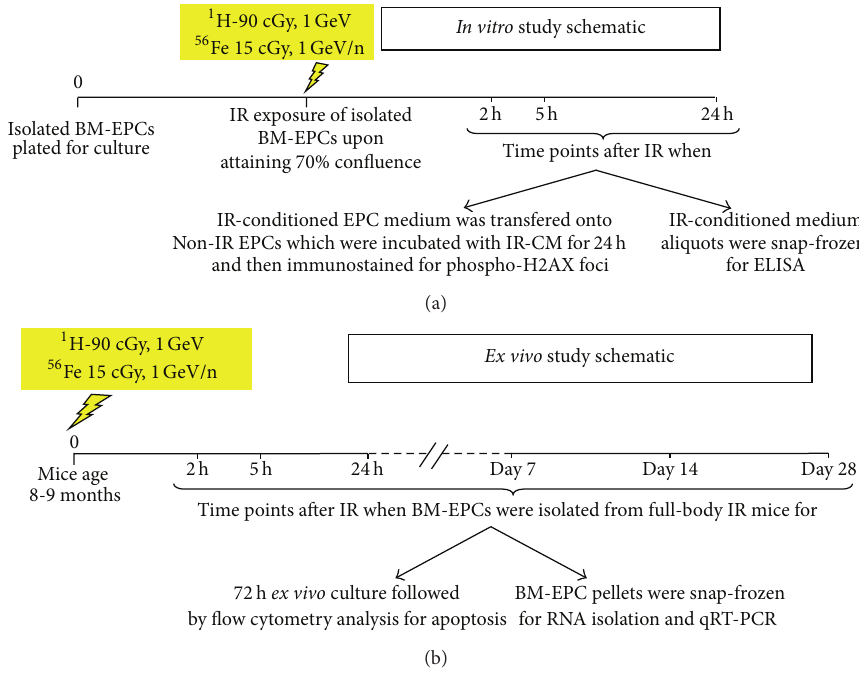
Figure 1: Diagrammatic representation of the experimental design to evaluate the effect of low-dose, whole body 90cGy, 1GeV 1 H and 15 cGy, 1GeV/n 56 Fe-IR in BM-derived EPCs of 8–10 months old C57BL/6NTac. (a) In vitro study schematic for IR-conditioned medium transfer study to evaluate bystander responses in nonirradiated BM-EPCs over 24-hour time period after IR. (b) Ex vivo study schematic to evaluate the effects of full-body IR over 28 days on survival of